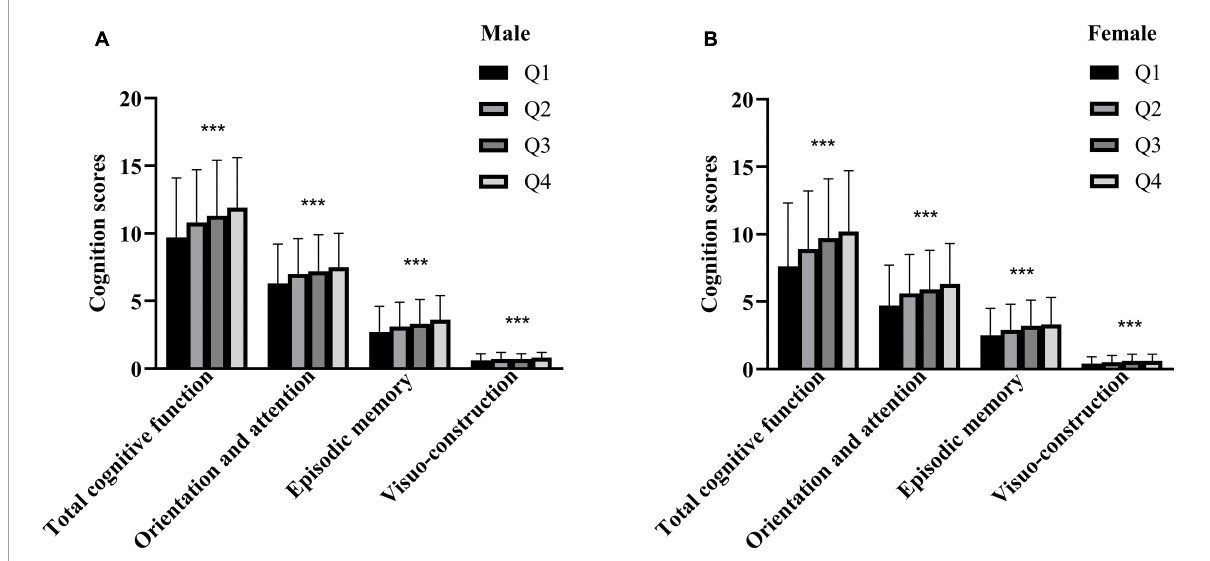
FIGURE1 Average cognition scores between groups divided by SI quartiles. (A) In the males, (B) in the females. ***The cognition scores among the four groups were significantly different ( P < 0.001).